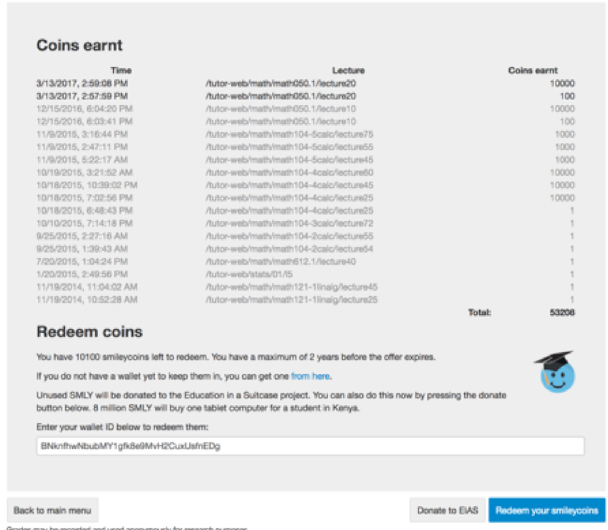
Fig. 4. Student view of SMLY earned in different tutor-web lectures along with buttons for redeeming the